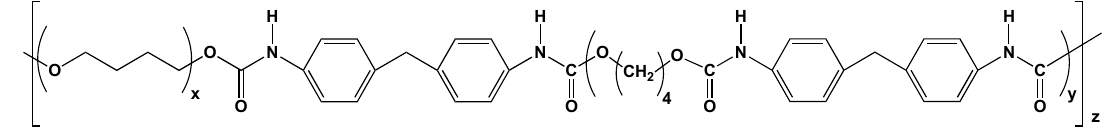
Figure 1. Structure of the hard segment of Pellethane ® . M n = 80,000, M w = 160,000.